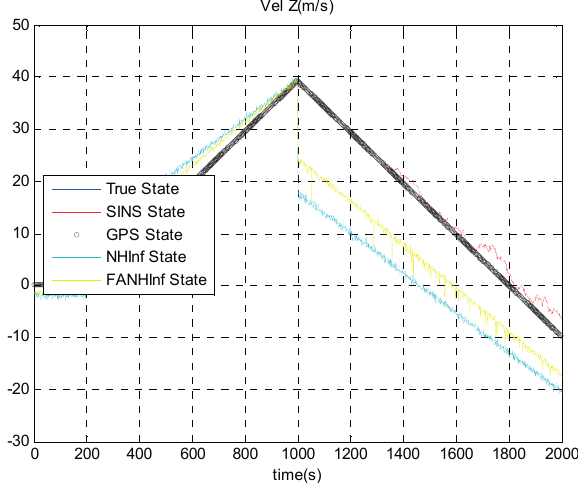
Figure 9. Estimation of the velocity following the Down axis.